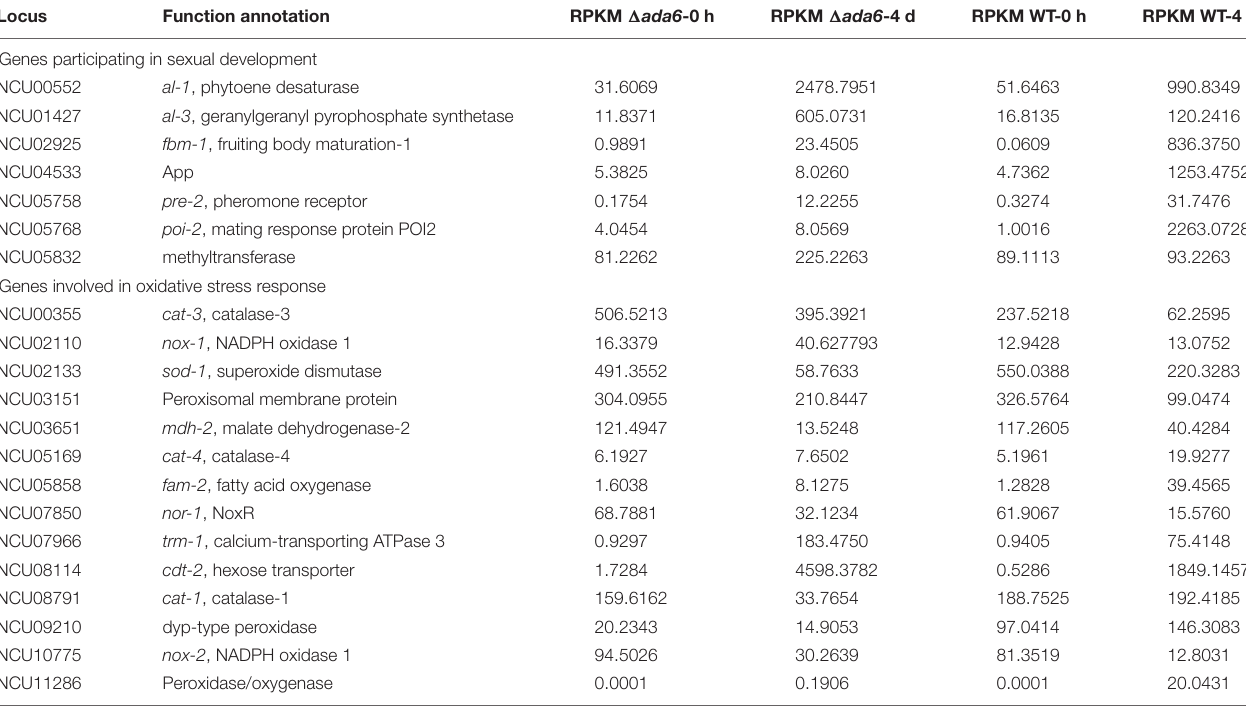
TABLE 4 | Transcriptional response to ada-6 deletion by the genes involved in sexual development and oxidative stress response. Locus Function